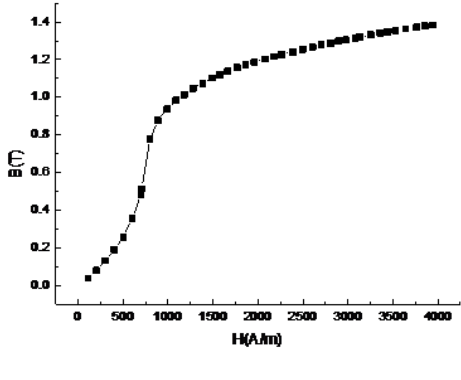
Fig. 7 The magnetisation curve of